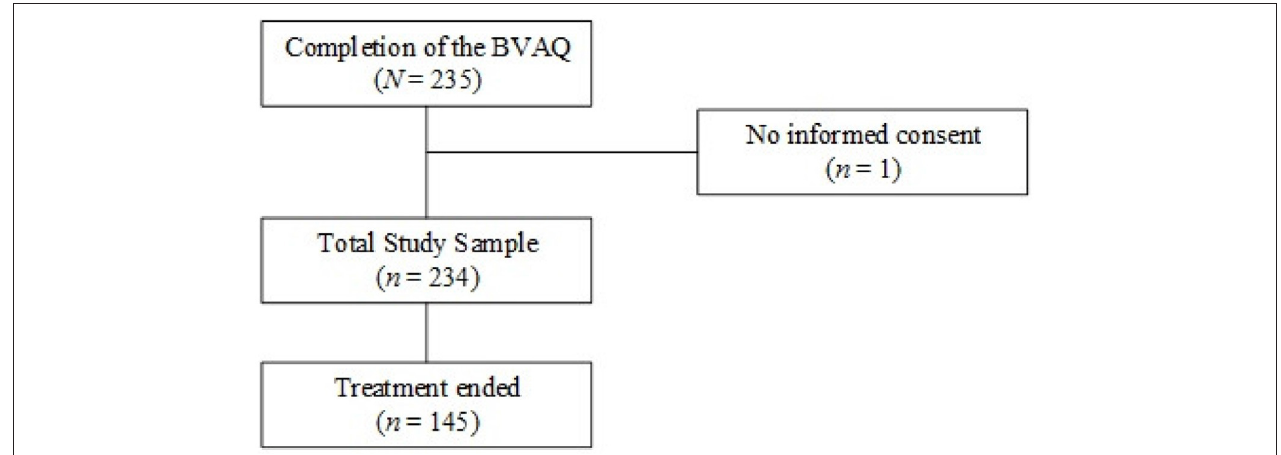
FIGURE 1 | Flowchart of patients included in the study. Sample sizes are given for patients who completed treatment and questionnaire assessment. BVAQ, Bermond-Vorst Alexithymia Questionnaire.